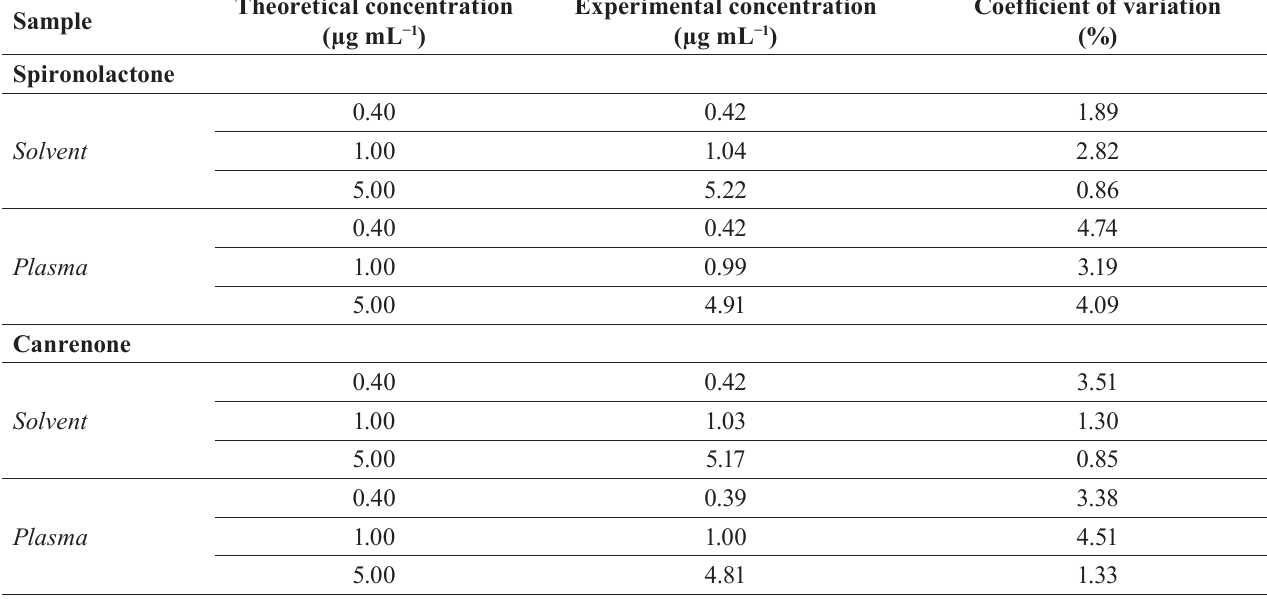
TABLE II – Results of the repeatability of the analytical method for the quantification of spironolactone and canrenone Sample